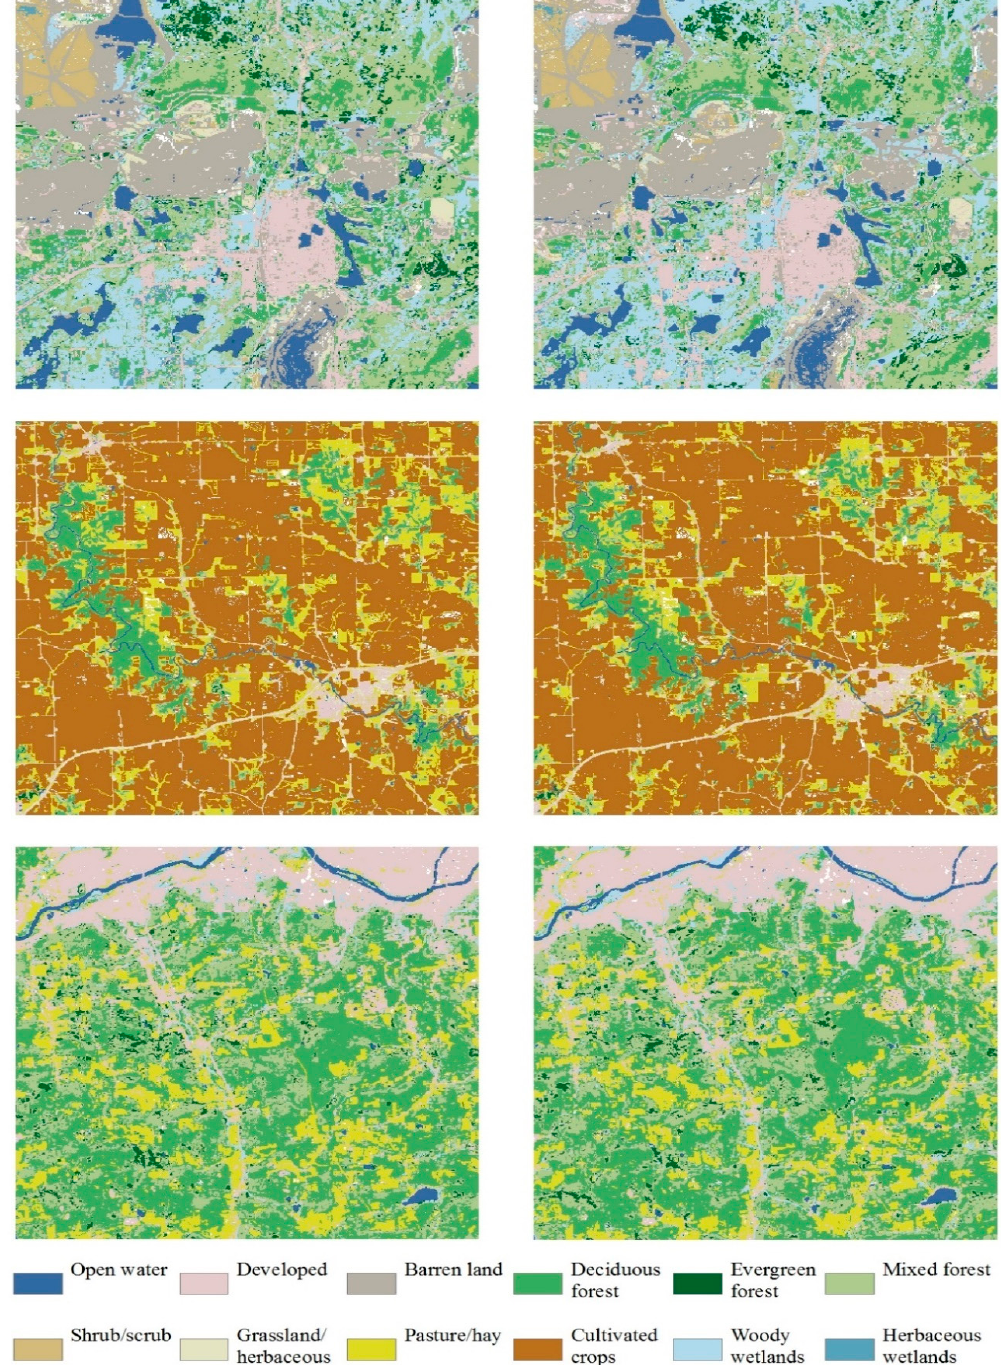
Figure 5. Spatially explicit classifications of the three study areas for the target year 2011. Left-hand column: the final classifications generated using 10 independent random forest (RF) supervised classification results of original percentiles. Right-hand column: the final classifications generated using 10 independent RF supervised classification results of proposed TSM-adjusted percentiles. Top: Minnesota classification results, middle: Iowa classification results, and bottom: New York classification results. Colors correspond to those used in Figure 1 except for the “Developed” class, which is rendered in light pink. White shows the pixel locations where land-cover changes occurred: these pixels were labeled as belonging to the “disturbed” class.